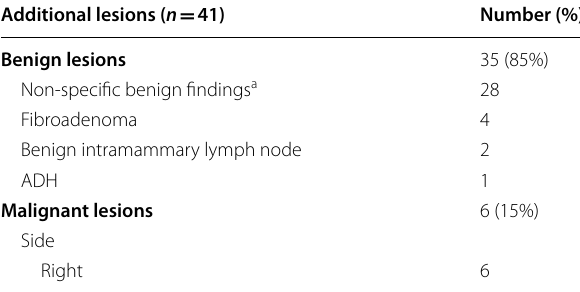
Table 2 Final diagnosis for the additional lesions as assessed